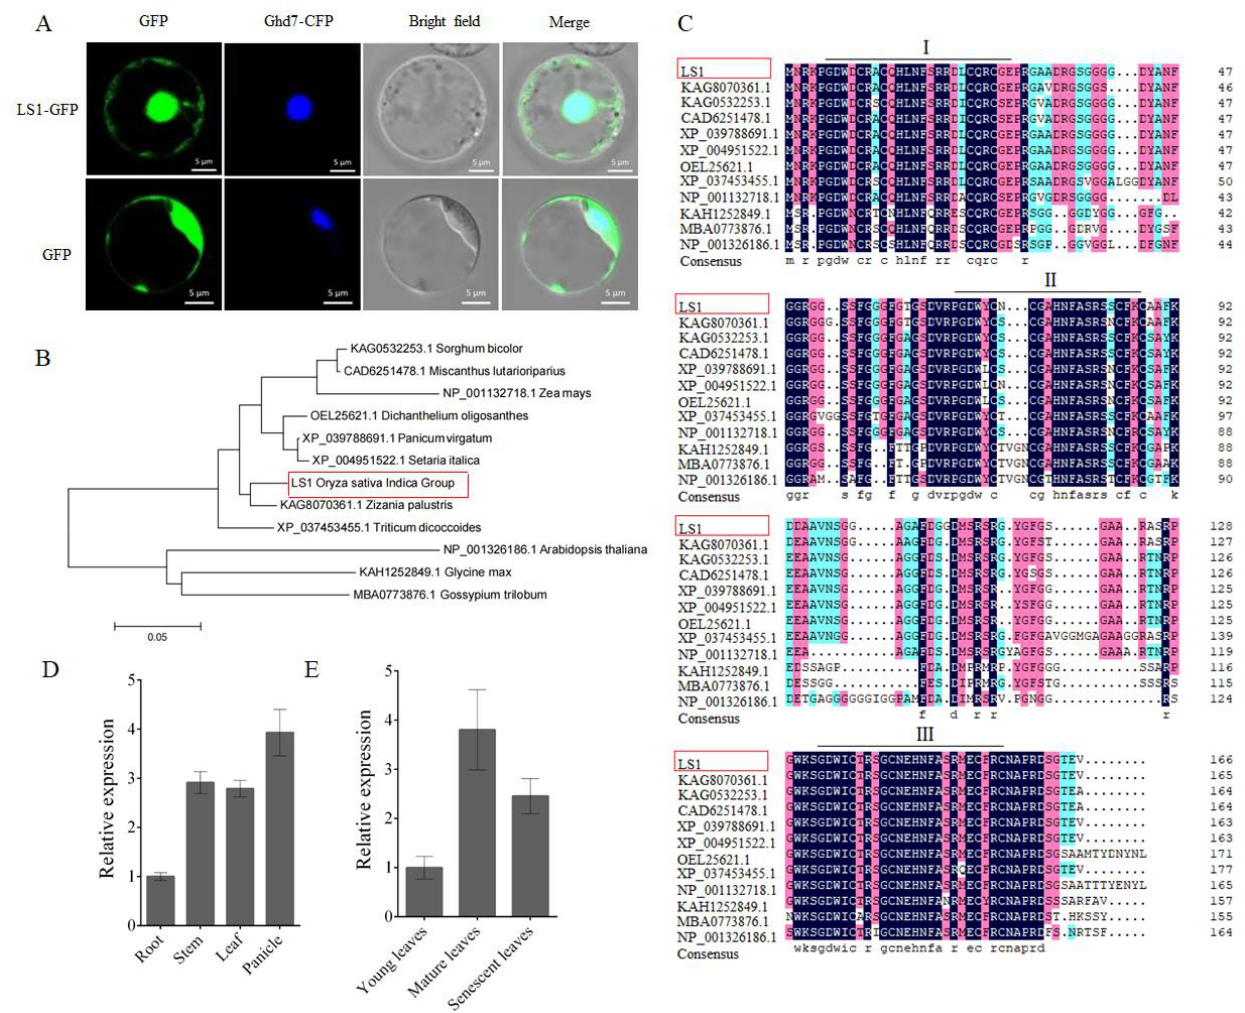
Figure 1. Expression assay and bioinformatic analysis of leaf senescence 1 ( LS1 ). ( A ) Subcellular localization of LS1. LS1 fused with green fluorescence protein (GFP) was transiently expressed in rice protoplasts. The bottom panels show the localization of GFP as the control. Scale bar = 5 µ m. ( B ) Phylogenetic tree analysis of the LS1 and its homologies. Each accession number represents a gene; their information is available in NCBI. ( C ) Multiple sequence alignment analysis of LS1 and its homologies. ( D ) Expression pattern of LS1 in various tissues. ( E ) Expression pattern of LS1 in the leaves at various developmental stages. The error bars indicate SDs of three biological replicates ( D , E